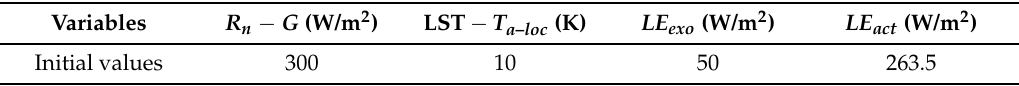
Table 6. The preset initial values of variables in the SEB-A method for the sensitivity analysis. Variables